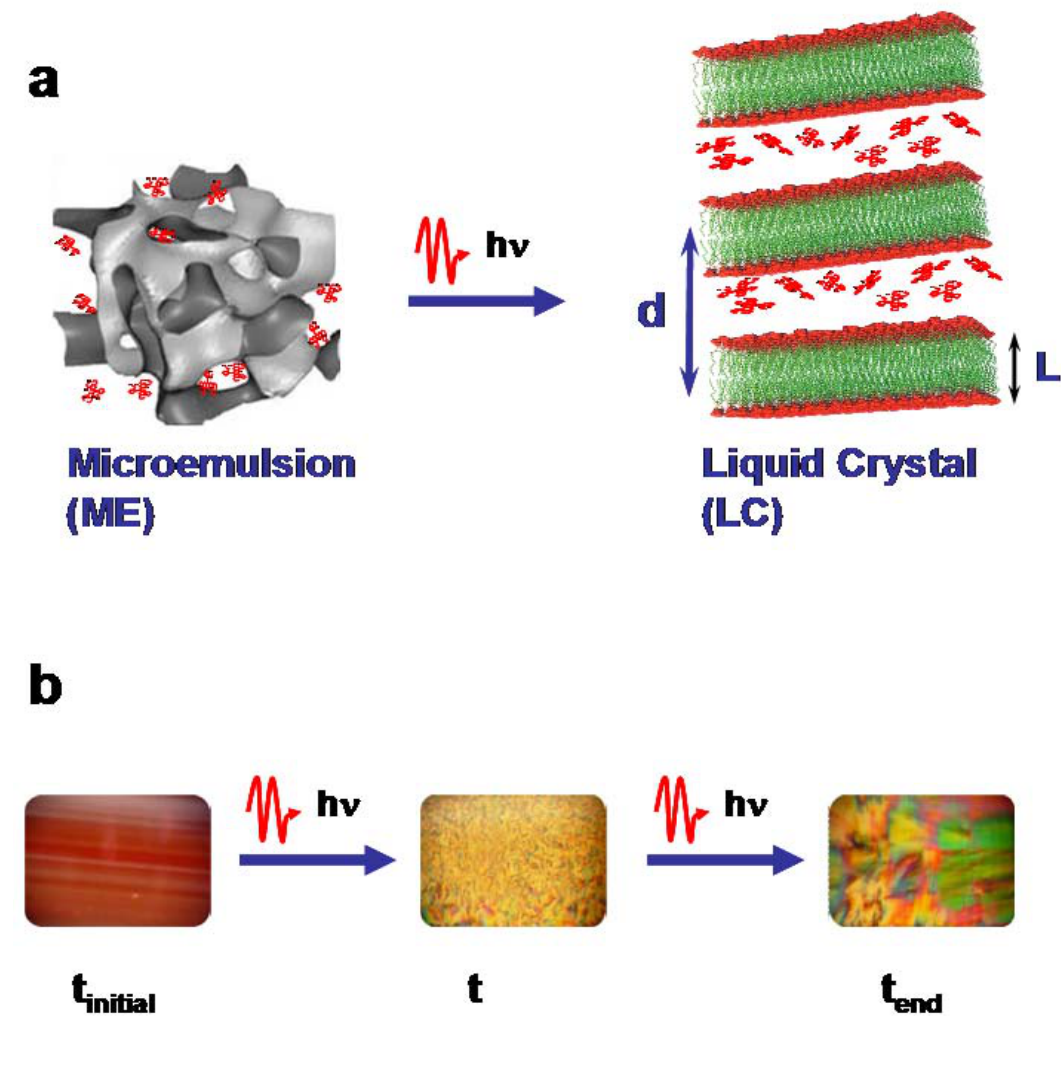
Figure 1. Schematic drawing of the principle of the photo-induced phase transitions (PIPT) in ternary systems from a microemulsion (ME) to a liquid crystal (LC) phase. (a ) Structural phase transition, ( b ) optical photographs of the system C ne/cyclohexane enriched with Rh101. Microemulsion (left), liquid crystals after partial (middle) and complete (right) transformation. The photographs of the liquid crystal phases were taken with